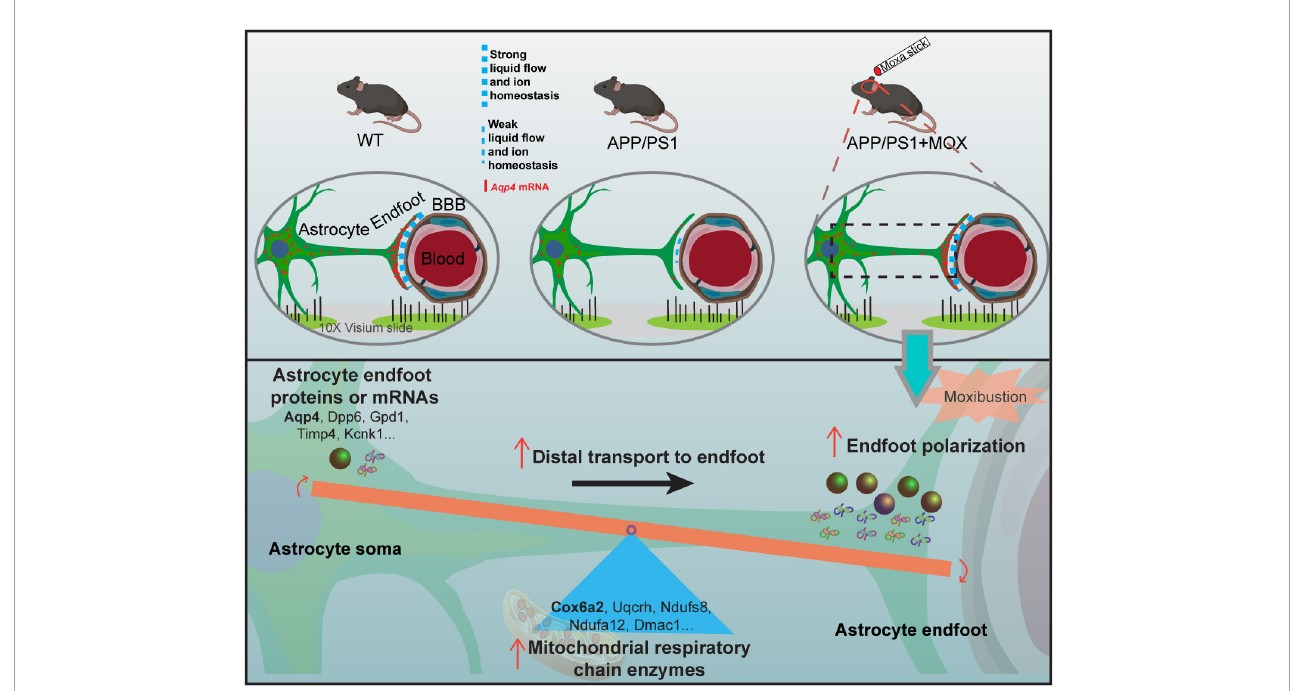
FIGURE7 The mechanism diagram of moxibustion improving Aqp4 polarization around cerebral vessels in APP/PS1